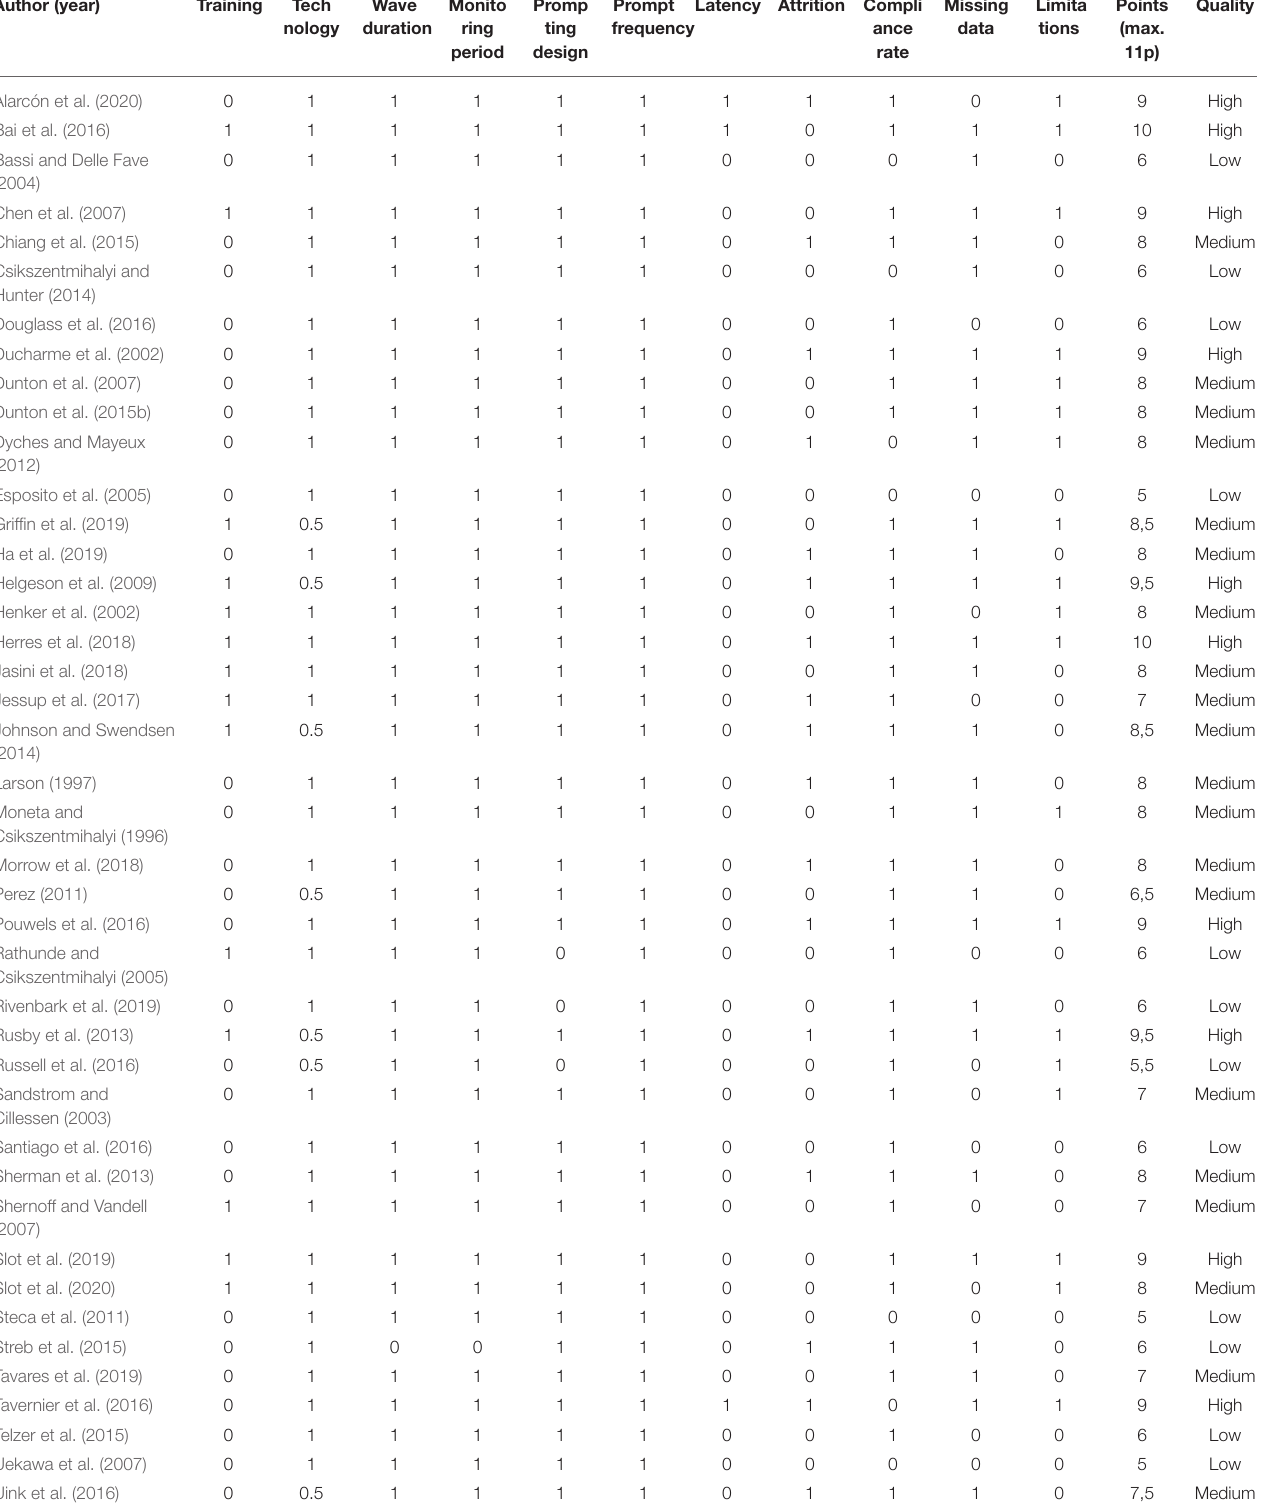
TABLE 2 | Quality appraisal of included studies ( N =